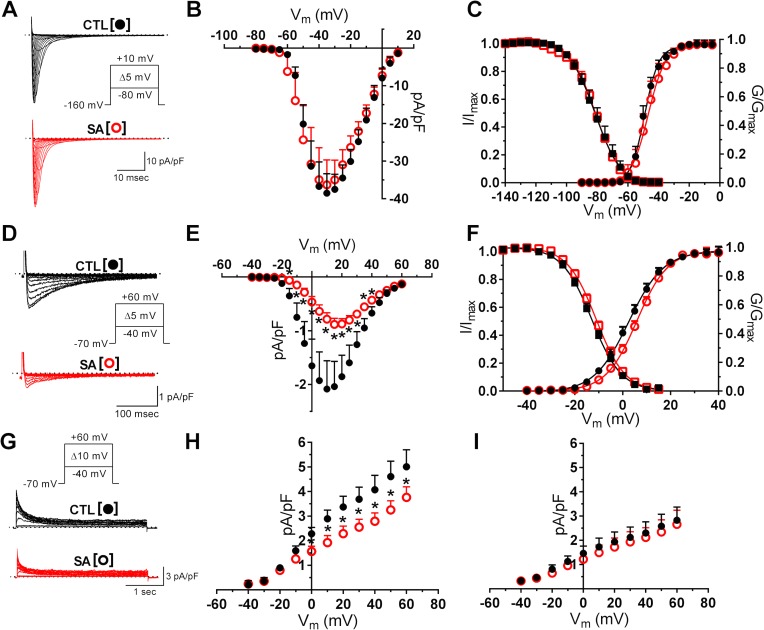
Voltage-gated ionic currents are differentially affected by stearic acid.Panel A: Representative traces of sodium currents (INa) in control (CTL, black) and in SA (10 μm; red) treated cells. Inset: voltage-clamp protocol for current activation. Plots of current density (Panel B), and of voltage-dependence of current activation and inactivation (Panel C), n = 5, 7). Panel D: Representative traces (selected) of calcium current (ICa, L) in CTL and in SA (10 μm; red) treated cells. Inset: voltage-clamp protocol for current activation. Plots of current density (Panel E), and of voltage-dependence of current activation and inactivation (Panel F). Incubation of myocytes in SA caused a significant reduction of ICa, L density (n = 24, 22; *p<0.05). Panel G: Transient outward potassium currents (ITO) in CTL and in SA treated cells. Inset: voltage-clamp protocol. Panel H: Current-density measurements showing effects of SA on peak ITO, but not on the steady state current (ISS) (Panel I) (n = 8, 8; *p<0.05).